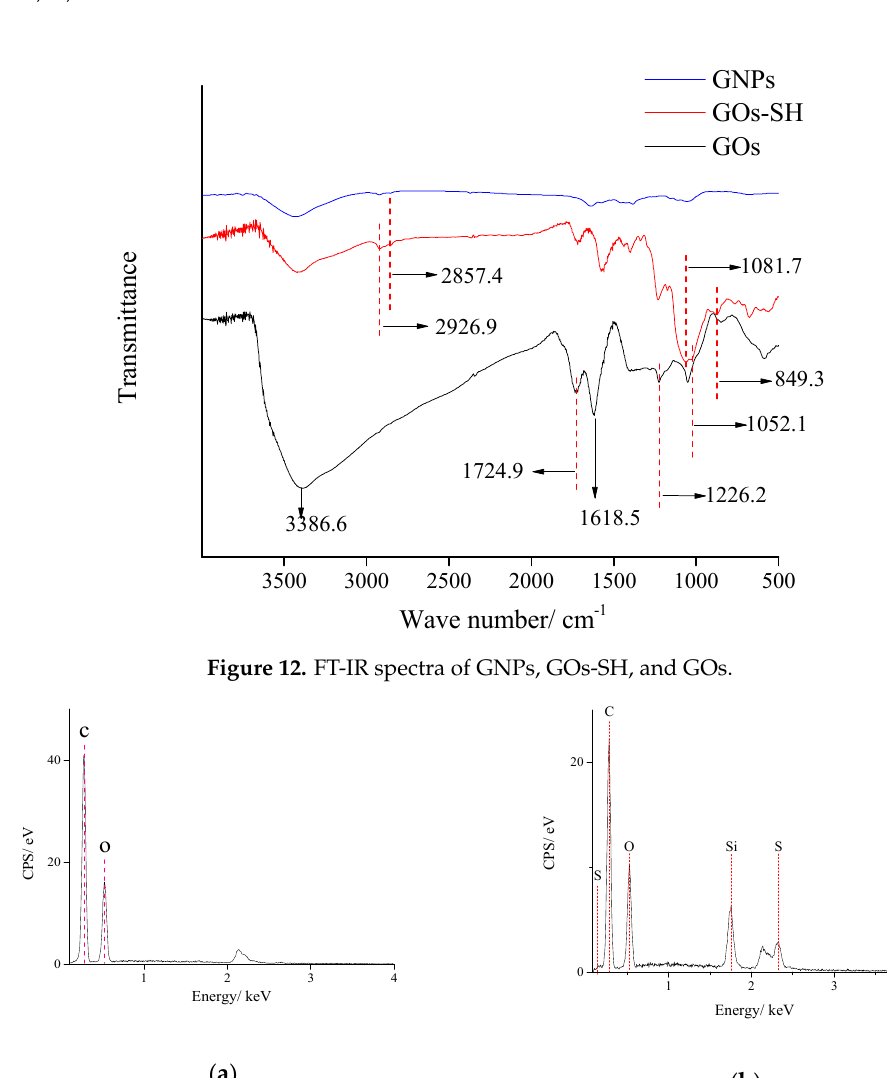
Figure 13. EDX analysis chart of GOs ( a ) and GOs-SH ( b ).